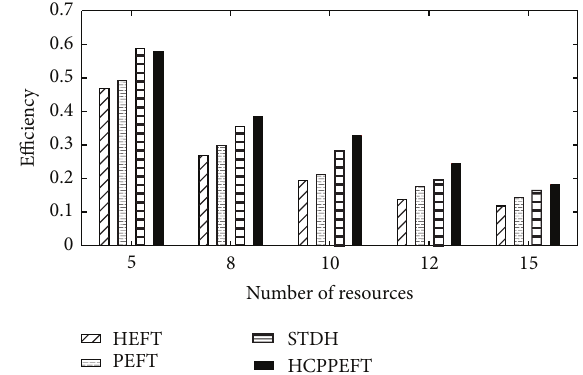
Figure 8: Efficiency for different numbers of